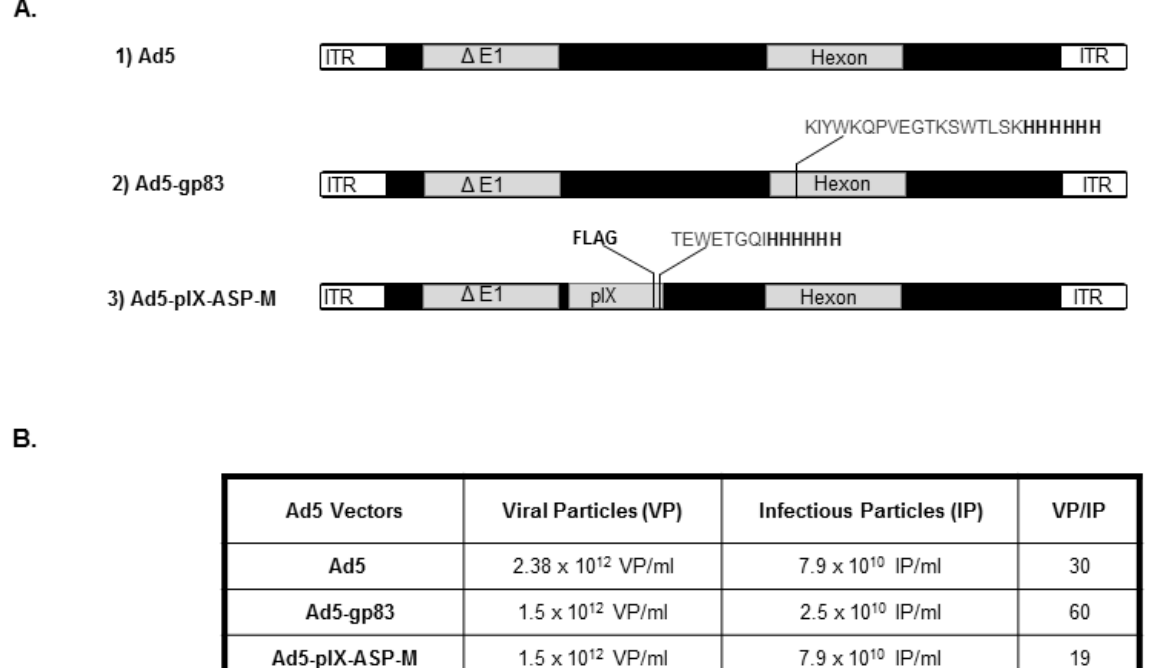
Figure 1. Schematic representation of the T. cruzi ASP-M epitope and His epitope genetically incorpo- 6 rated into the pIX of Ad5 and T. cruzi gp83 epitope incorporated into the hexon of Ad5 (A), and viro- logical properties of vectors (B). (A): (1) Ad5, a replication-defective adenovirus with wildtype pIX. (2) Ad5-gp83, Ad5 replication-defective genome containing an incorporated neutralizing T. cruzi trypomasti- gote gp83 epitope within the hexon locale. (3): Ad5-ASP-M, Ad5 replication-defective genome containing an incorporated T. cruzi amastigote ASP-M epitope within the pIX locale. (B): VP/IP